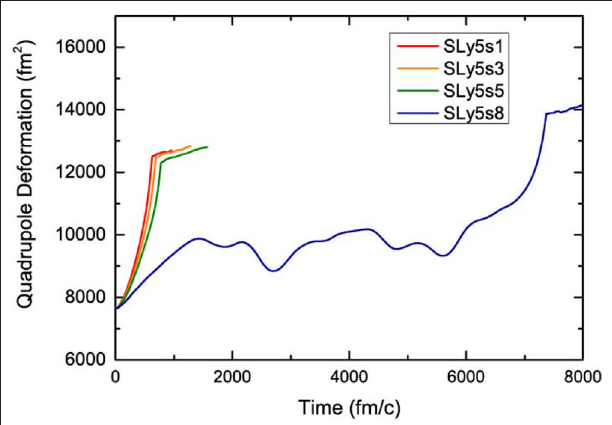
calculated potential energy curves of SLy5s X forces as a function of quadrupole deformations β 2 are shown in Figure 1 . The two- dimensional potential energy surfaces of 240 Pu from different calculations can be found in [5, 36, 37]. The SLy5s8 has the largest surface energy and SLy5s1 has the smallest surface energy.